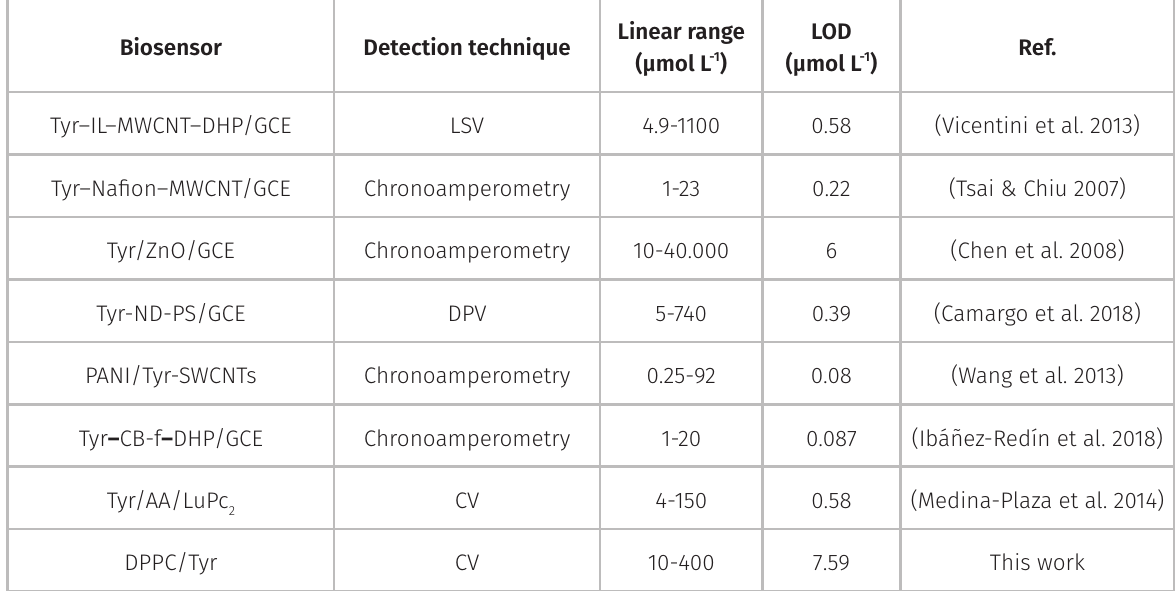
Table II. Comparison of analytical parameters of Tyr biosensors for catechol.